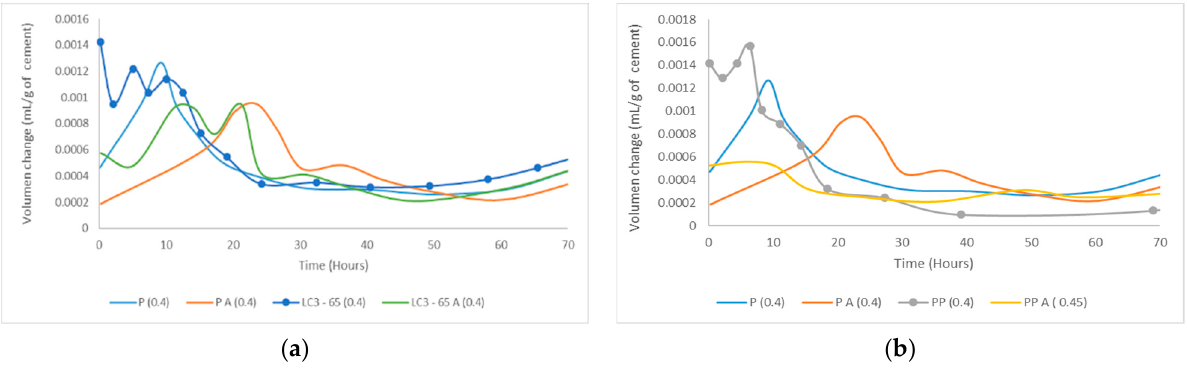
Figure 3. Effect of chemical admixtures on volume changes in paste: ( a ) combinations of OPC and LC2 binder, ( b ) pozzolanic cement containing 15% of natural pozzolan (PPC) binder.